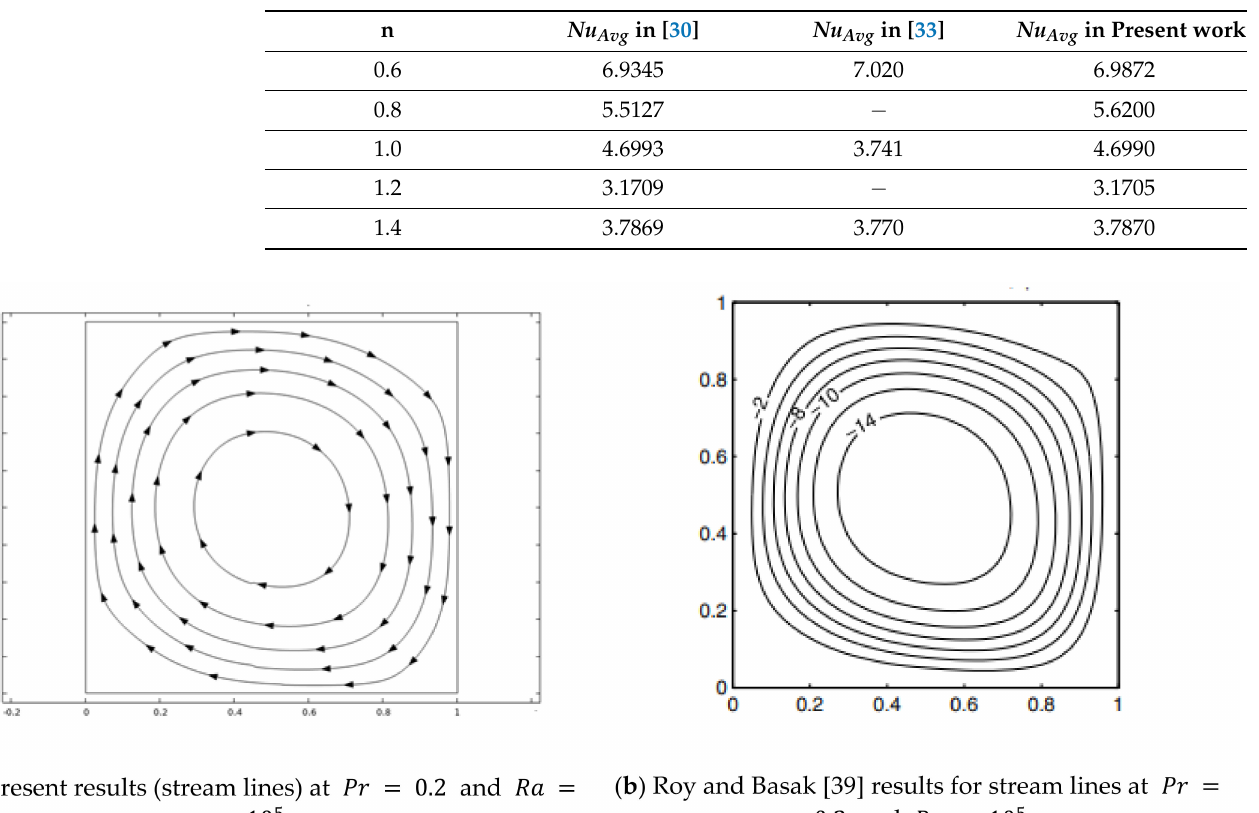
Table 2. Comparison of average Nusselt number Nu Avg against ( n ) .